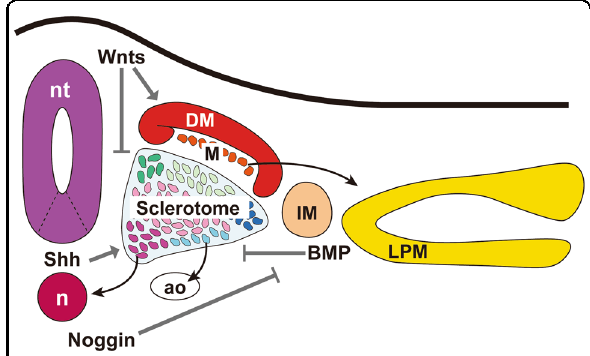
Fig. 2 Schematic of the relationship between the sclerotome and other tissues. A large part of the sclerotome is induced depending on Shh signaling from the notochord and fl oor plate. Shh also competes with Wnt, which induces the dermomyotome and maintains the epithelial state in somites. The notochord also produces Noggin, which inhibits BMP signaling and supports sclerotome induction 63 . nt neural tube, n notochord, ao dorsal aorta,